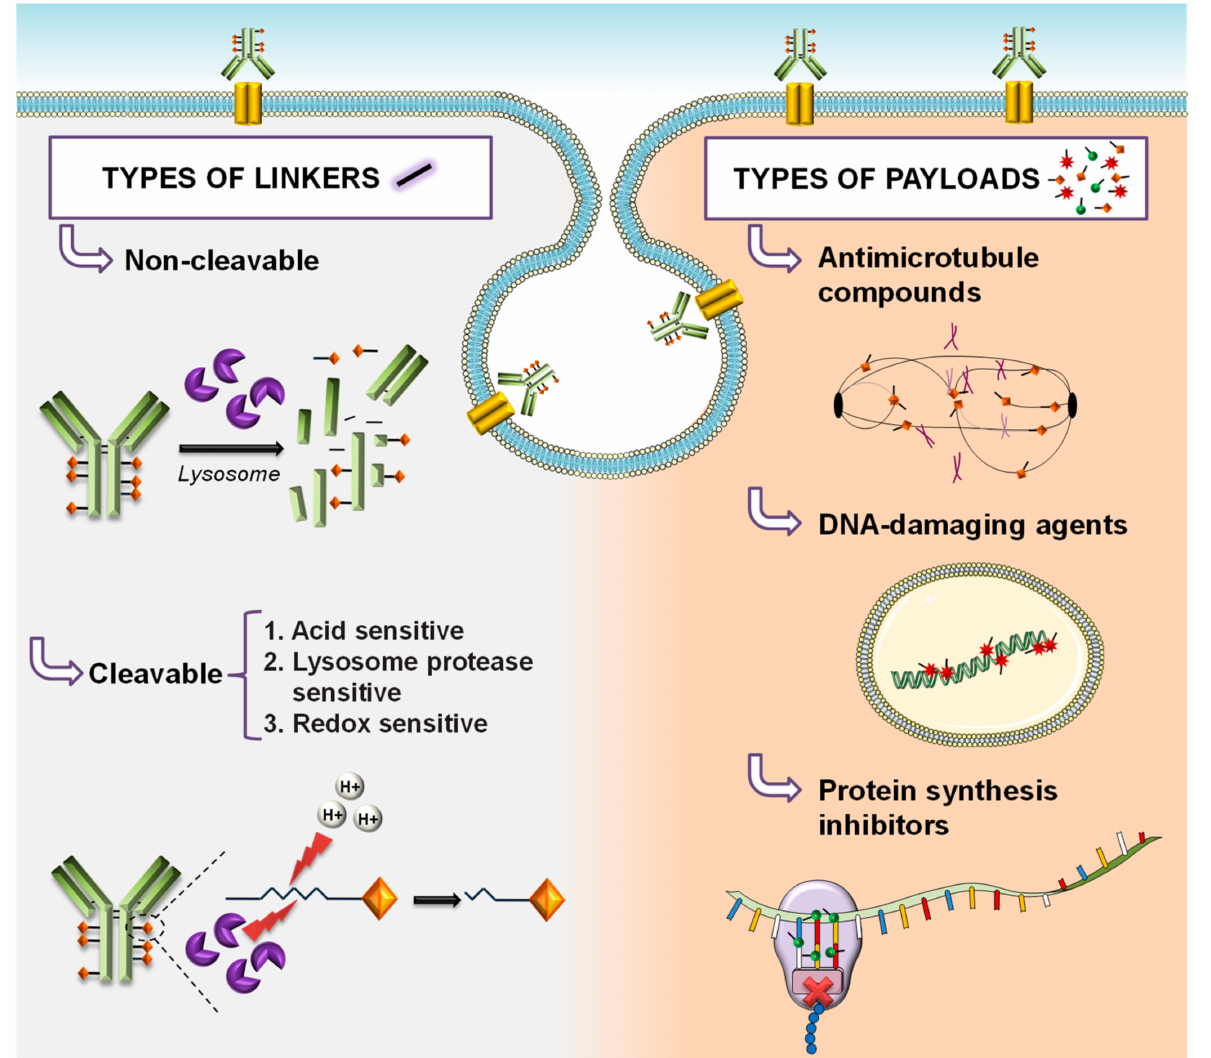
Figure 2. Types of linkers and payloads in ADC